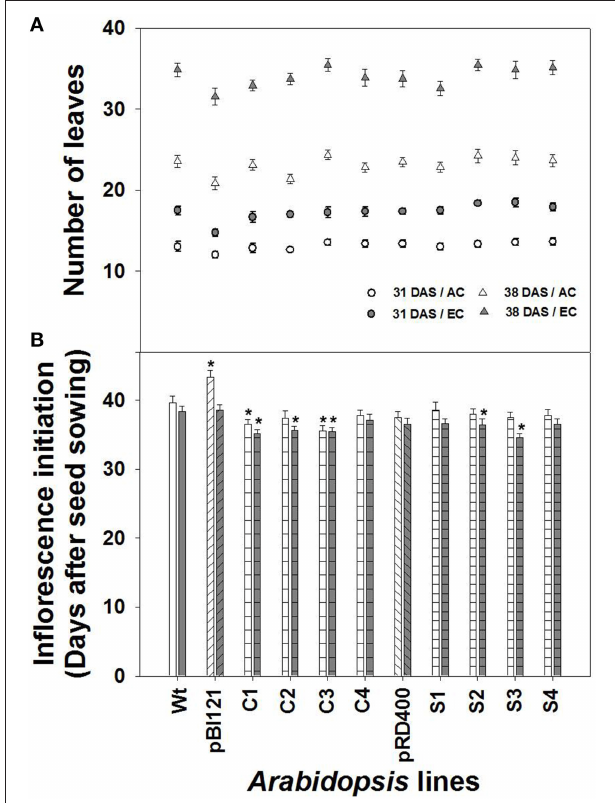
FIGURE 2 | Comparison of rosette leaf number and inflorescence initiation over time in Arabidopsis lines grown at either AC or EC. Total rosette leaf numbers at 31 and 38 DAS (A) and the number of days required for visible inflorescence initiation (B) are presented. In (A) , the data at 38 DAS represents the final leaf numbers at the end of the vegetative phase. CO 2 treatments: 380 ppm (AC, open circles or triangles), 700ppm (EC, closed circles or triangles). Asterisks ( * ) indicate results significantly different from wild-type (WT) at α = 0.05. Values represent the mean ± SE; n = 10 plants per